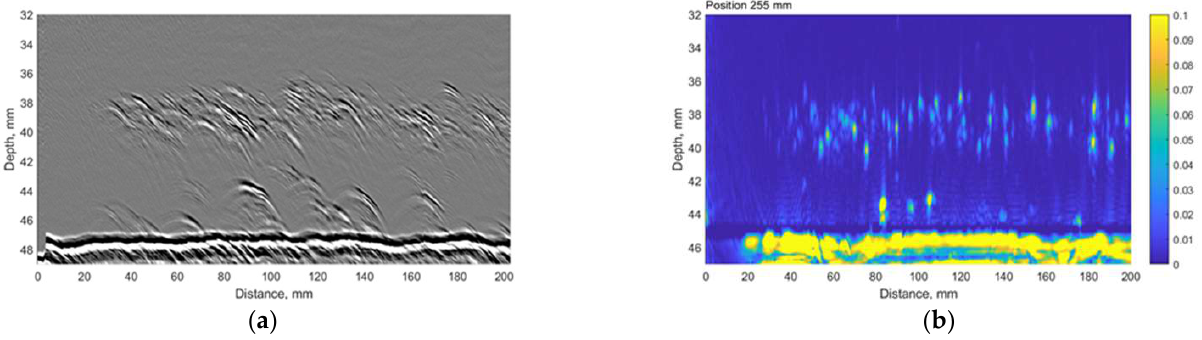
Figure 15. The comparison between ( a ) TULA and ( b ) TFM measurements at 255 mm circumferential scan position. Vertical colour bar represents the peak-to-peak amplitude in arbitrary units.